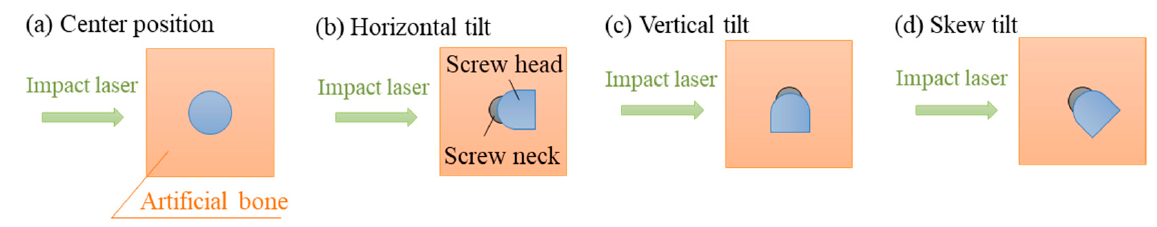
Figure 3. Experimental setting for evaluation of different head directions: ( a ) center position, ( b ) horizontal tilt, ( c ) vertical tilt, and ( d ) skew tilt.